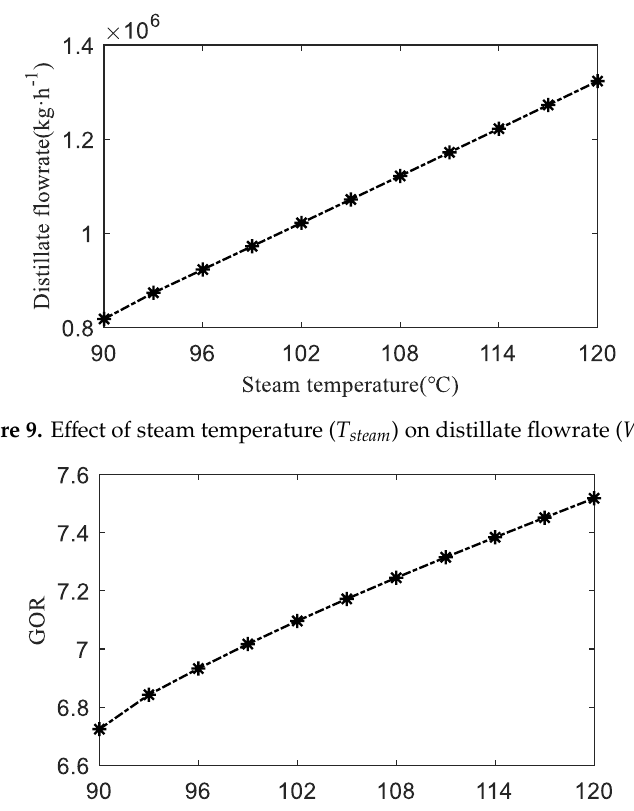
Figure 10. E ff ect of steam temperature ( T steam ) on Figure 10. Effect of steam temperature ( steam T ) on GOR.